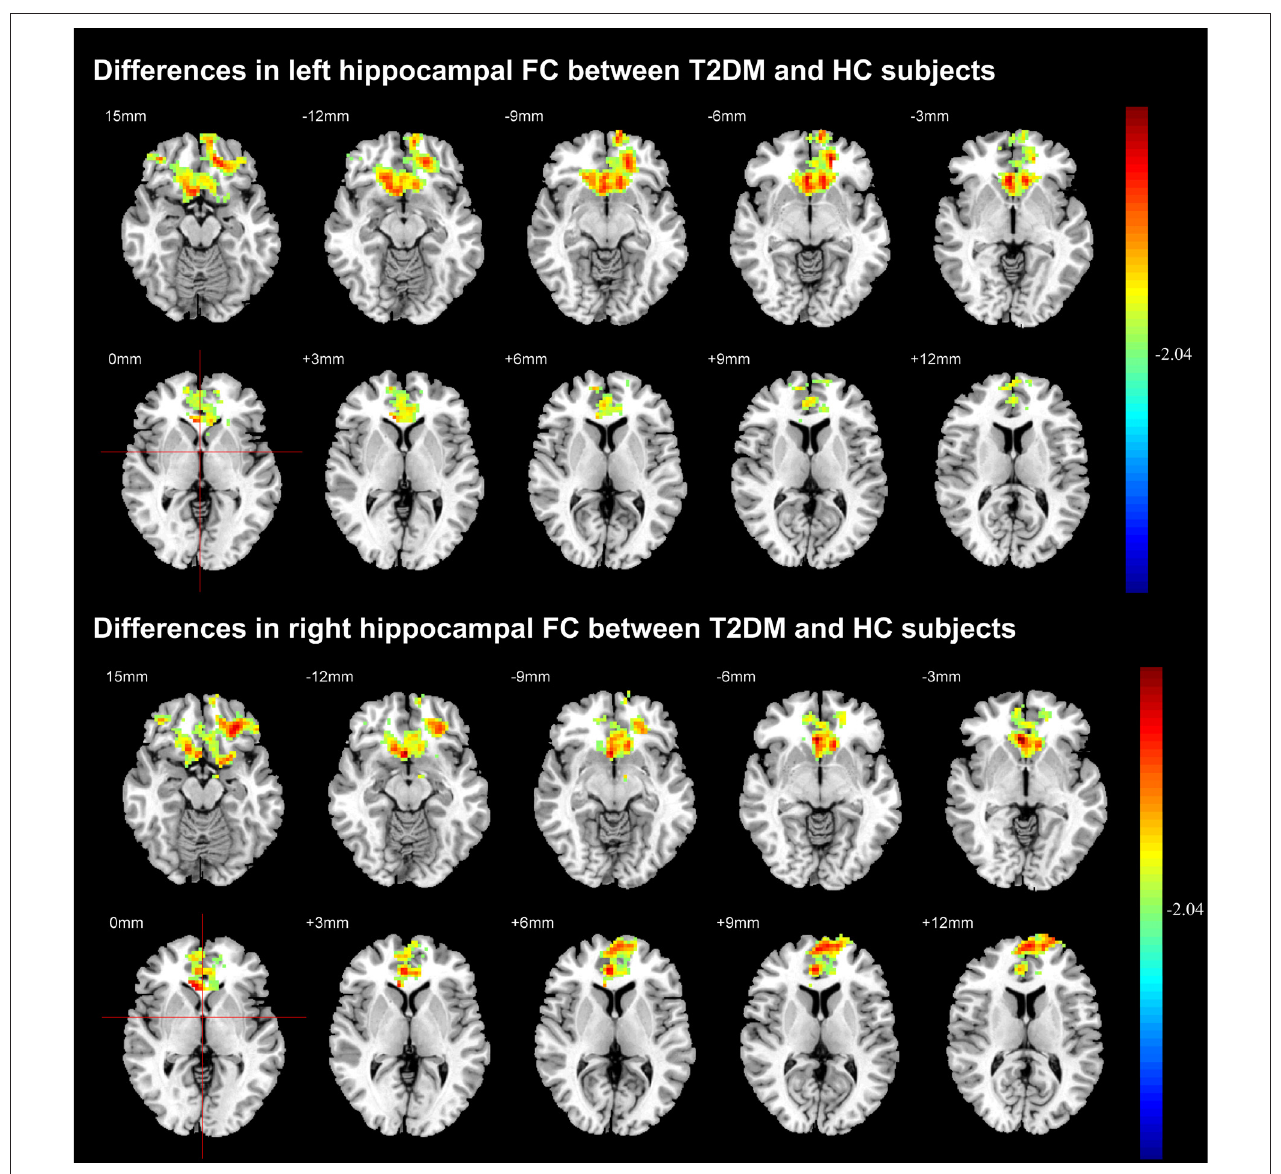
FIGURE 4 | Significant difference in the functional connectivity (FC) of hippocampal region between T2DM and HC groups. The color scale represents the strength of hippocampal FC (decreasing strength from green to red) in axial images. The threshold was set as P < 0.05, AlphaSim